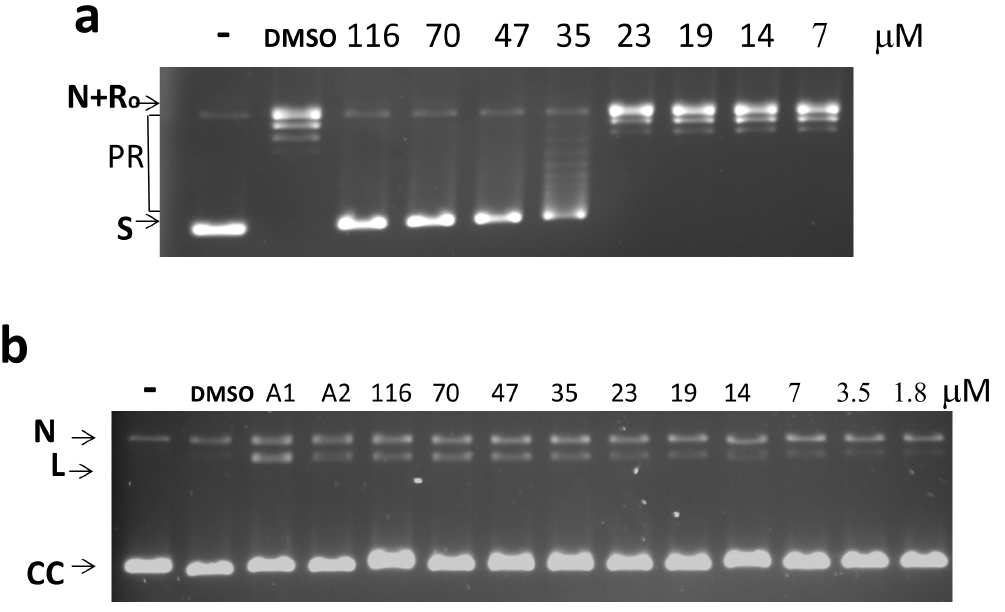
Figure 8. Effect of anziaic acid on human topoisomerase II a activity. (a) Assay of relaxation activity –1 U of enzyme was used in each relaxation reaction with 250 ng of supercoiled plasmid DNA in the presence of 0.0025% Tween 20. (b) DNA cleavage assay with 5 U of enzyme. Gel electrophoresis was carried out in the presence of 0.5 m g/mL ethidium bromide and m-AMSA was used as a positive control at 25 m M (A1) or 8 m M (A2). -: no enzyme. S: supercoiled plasmid DNA substrate. N: nicked plasmid DNA. Ro: Relaxed closed plasmid DNA. PR: partially relaxed plasmid DNA. L: linear DNA. CC: covalently closed circular DNA.